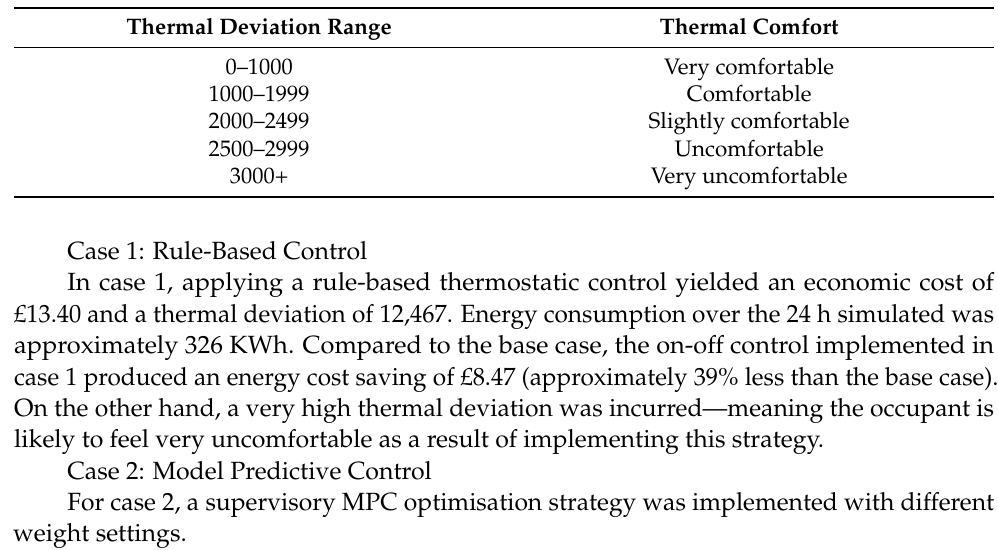
Table 2. Thermal deviation/comfort